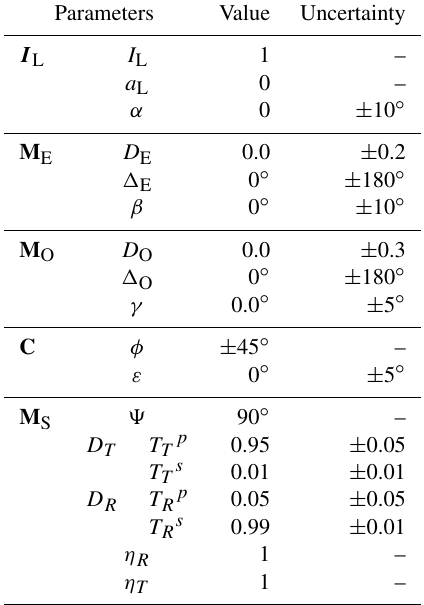
Table 2. Values and uncertainties of the synthetic lidar parameters. Parameters Value Uncertainty